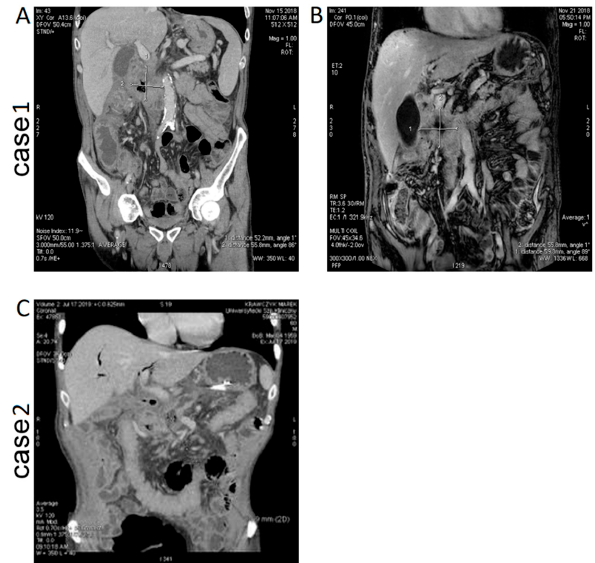
Figure 2. Patients’ imaging after the IRE procedure: ( A ) Case 1. In the follow-up CT examination, 3 months after electroporation, a slight reduction in the size of the pancreatic tumor was found, with the presence of features of internal lysis. The presence of air inside the tumor was related to fistula between the pancreatic ducts and the tumor, and inflammation was also found; ( B ) Case 1. In the follow-up MRI examination (T1 images, contrast-dependent) 3 months after the electroporation procedure, an area of necrosis lysis in the tumor (no enhancement and low signal) was found, ( C ) Case 2. The CT examination after the administration of the contrast agent showed necrosis of the tumor (visible in the